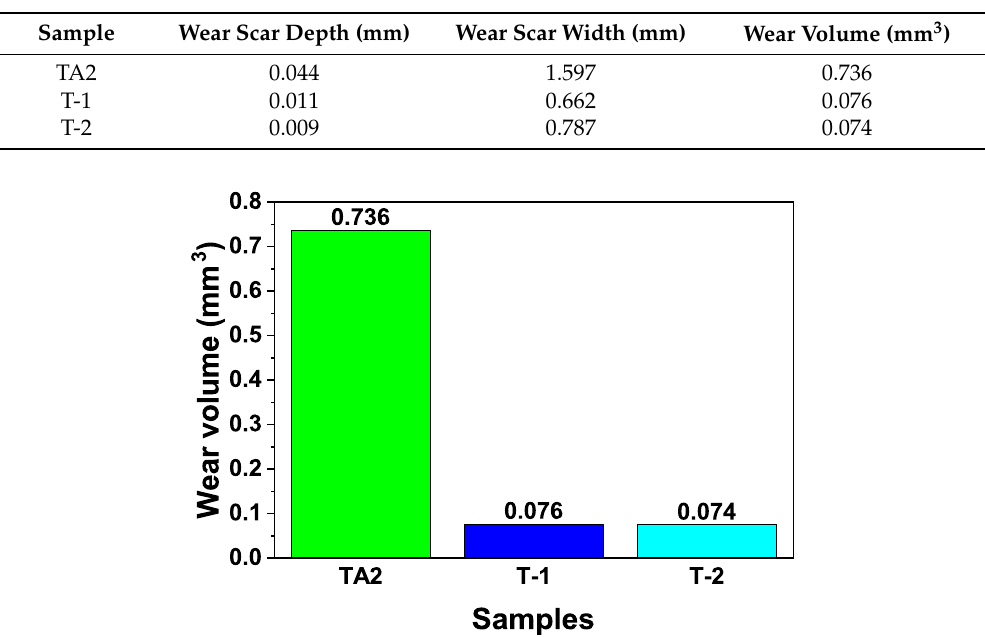
Figure 13. Wear volumes of TA2, T ‐ 1 and T ‐ 2.